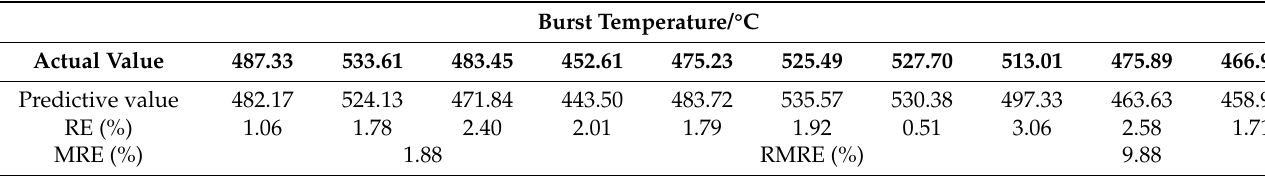
Table 9. Comparison of burst temperature prediction